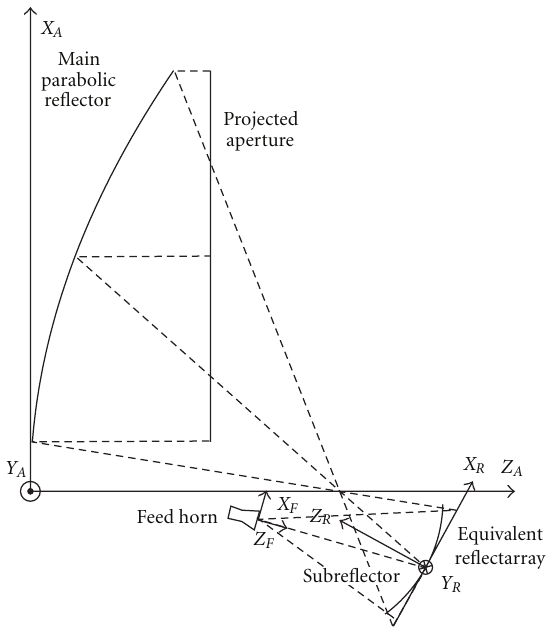
Figure 7: Scheme of the subreflectarray-parabolic reflector